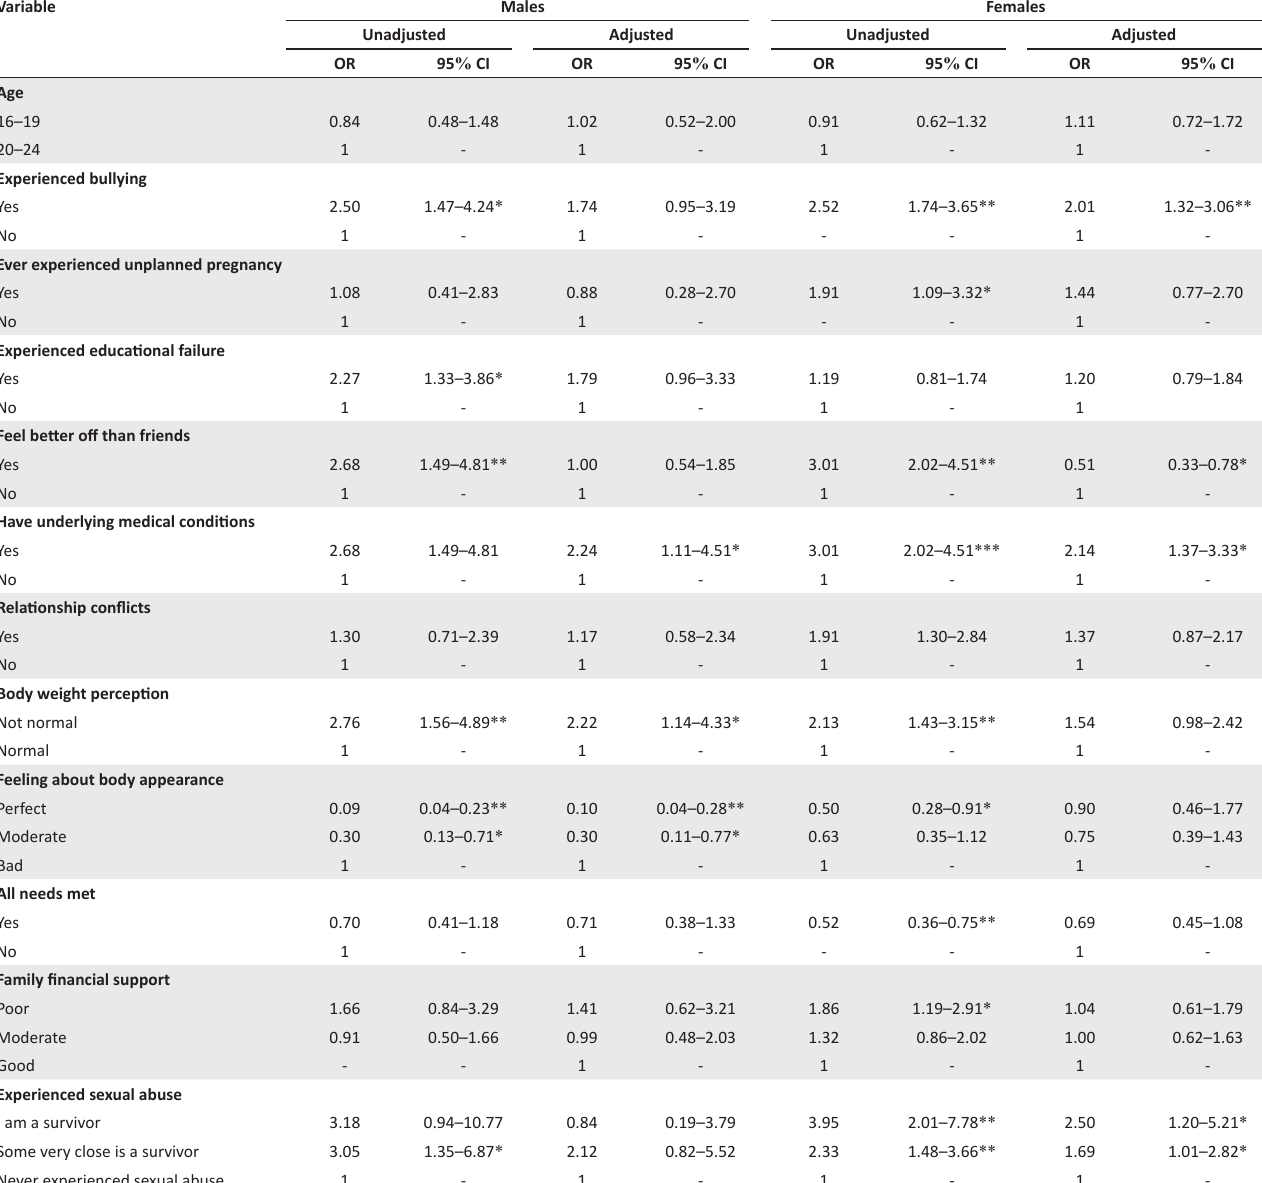
TABLE 3: Multiple logistic regression model analysis showing factors associated with suicidal ideation amongst males and females.